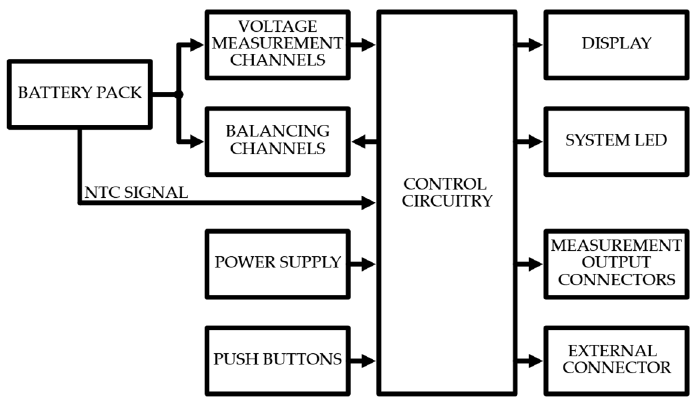
Figure 2. System block diagram.